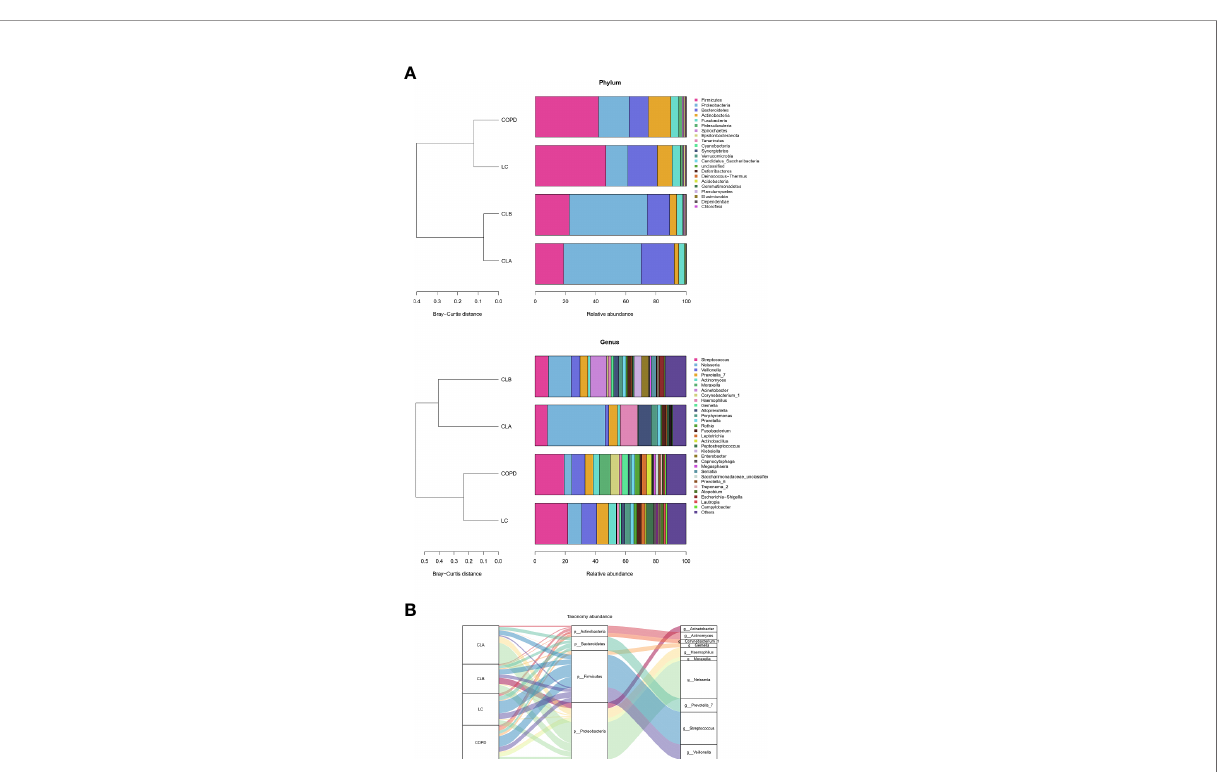
FIGURE 4 | Comparison of the phyla and genera of the microbiomes among the CLA (surgical treatment), CLB (non-surgical treatment), COPD (chronic obstructive pulmonary disease), and lung cancer (LC) groups. (A) Comparison of the abundances of the bacterial phyla ( left ) and genera ( right ) of each group. (B) Sankey plots of the relative abundances of the discriminatory bacterial phyla and genera among the groups.